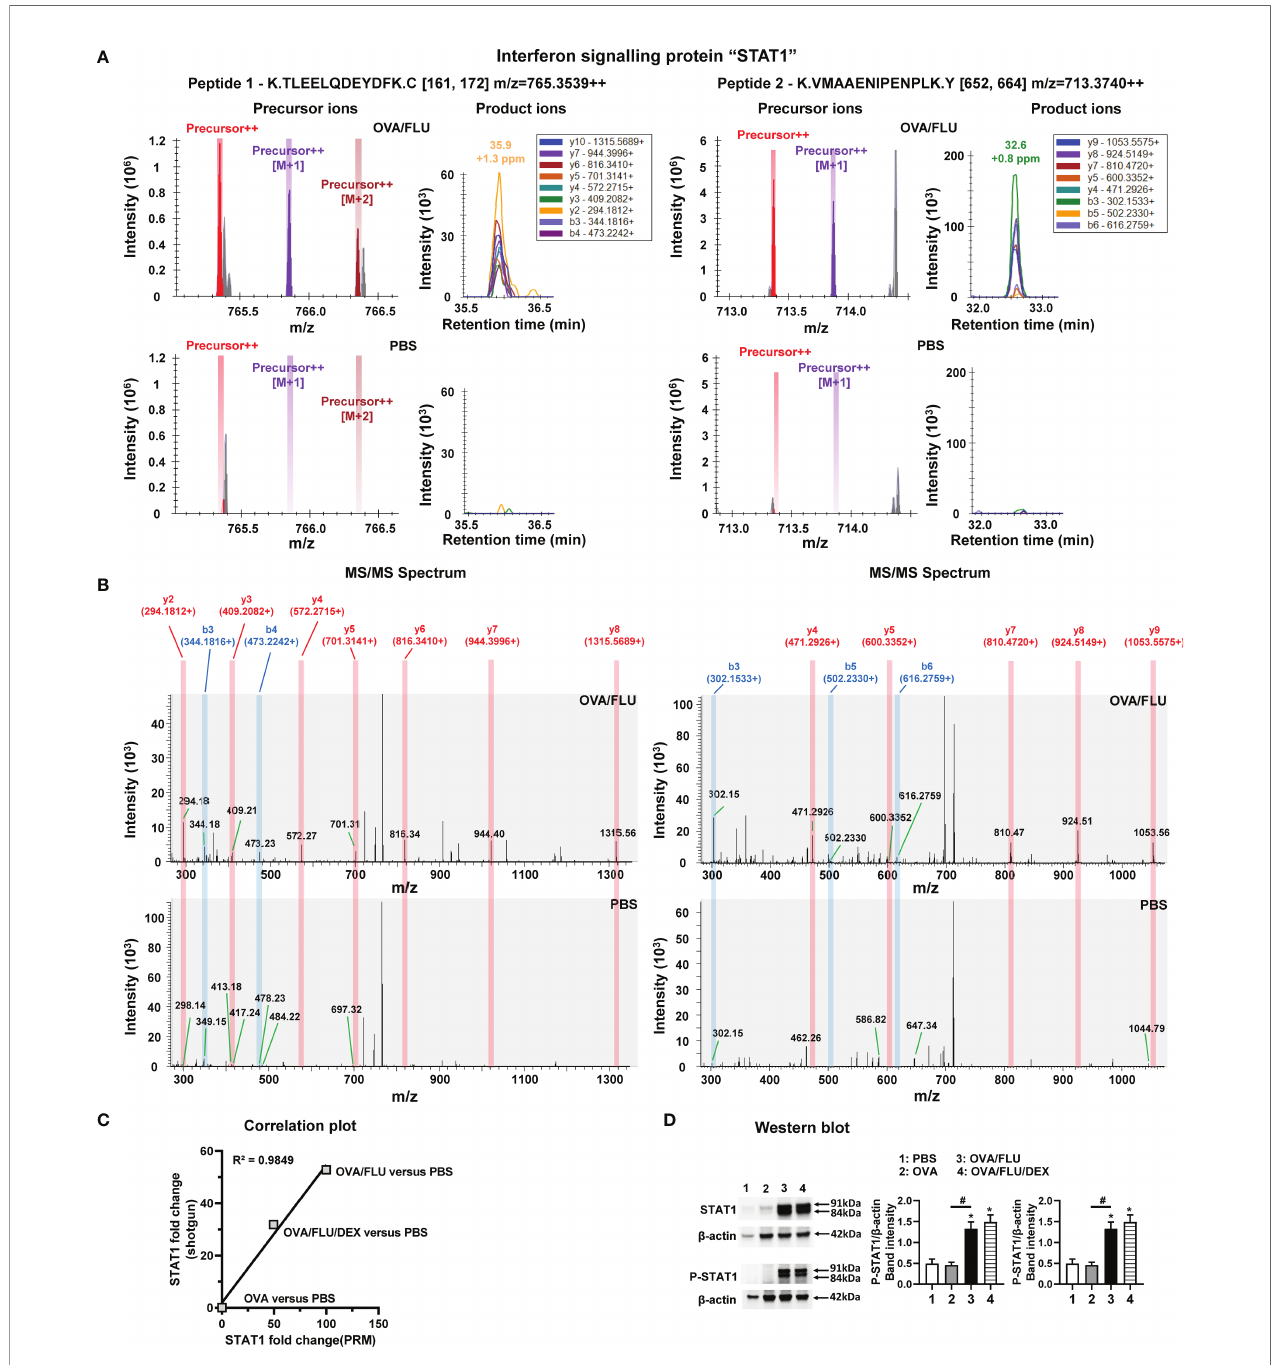
FIGURE 4 | Parallel Reaction Monitoring (PRM) mass spectrometry and western blot of STAT1 protein expression. PRM mass spectrometry detected and quanti fi ed two unique peptides of STAT1, K.TLEELQDEYDFK.C (peptide 1) and K.VMAAENIPENPLK.Y (peptide 2), in OVA/FLU and OVA/FLU/DEX but not OVA or PBS groups (OVA/FLU versus PBS is shown as an example). (A) A serial precursor ions (each color bar represents one precursor ion), as well as their corresponding y and b product ions (each color peak represents one product ion) for both peptides, were accurately detected in the OVA/FLU but not PBS group. (B) MS/MS spectrum for both peptides validated that all y (labeled in red) and b (labeled in blue) product ions for both peptides of protein were accurately detected in the OVA/FLU but not in PBS group. (C) The correlation plot represents the quanti fi cation results of STAT1 (OVA or OVA/FLU OVA/FLU/DEX or versus PBS) obtained between shotgun label- free proteomic and PRM proteomic. The coef fi cient of linear regression (coef fi cient of determination R 2 ) is 0.9849. (D) Western blot of the two isoforms of STAT1 (Stat1 a , Stat1 b ) and the phosphorylated STAT1 (P-STAT1, on site Tyr 701) (phospho-Stat1 a /phospho-Stat1 b ). b -actin (42 kDa) was used as a loading control. The relative quanti fi cation of STAT1 was performed using Image Lab software 6.1. Results are representative of three independent experiments. *Designates signi fi cant differences compared to PBS group (*p < 0.05); #Designates signi fi cant differences compared to OVA/FLU treated group ( # p <